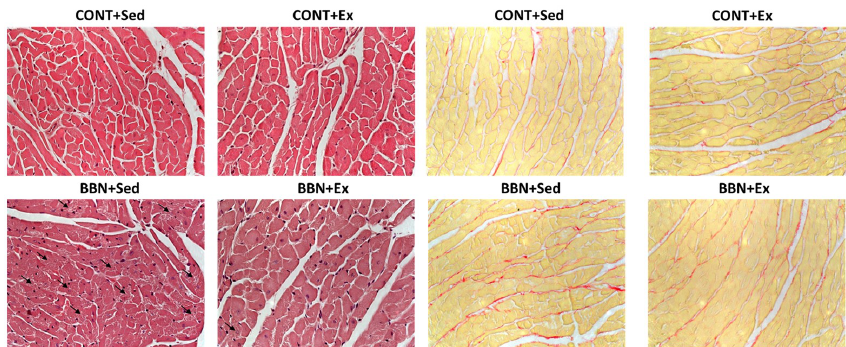
Figure 3. Effect of BBN exposure and/or exercise training on histological appearance of cardiomyocytes stained with hematoxylin and eosin, and on myocardial fibrosis given by Picrosirius red staining (red for collagen and yellow for cardiac muscle). All microscopic fields were obtained with a magnification of 400×.